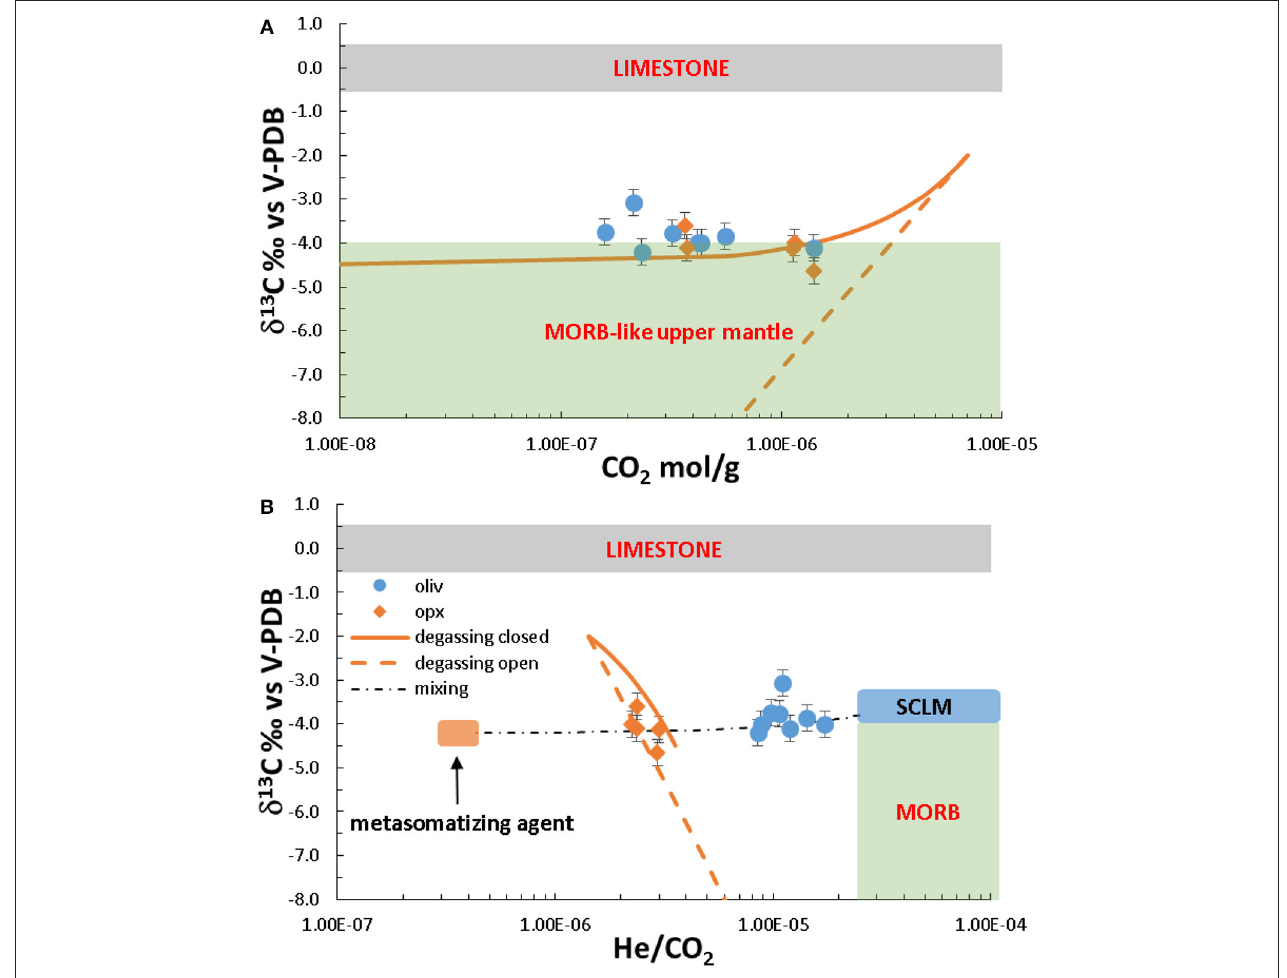
FIGURE 7 | (A) CO 2 concentration and (B) He/CO 2 vs. the C-isotope composition ( δ 13 C relative to V-PDB) in FI. The green bar [and rectangle in (B) ] indicates the range of δ 13 C values for a MORB-like mantle ( − 8 ‰ < δ 13 C < − 4 ‰ ; Sano and Marty, 1995), while the gray bar is for limestone ( − 1 ‰ < δ 13 C < + 1 ‰ ; Sano